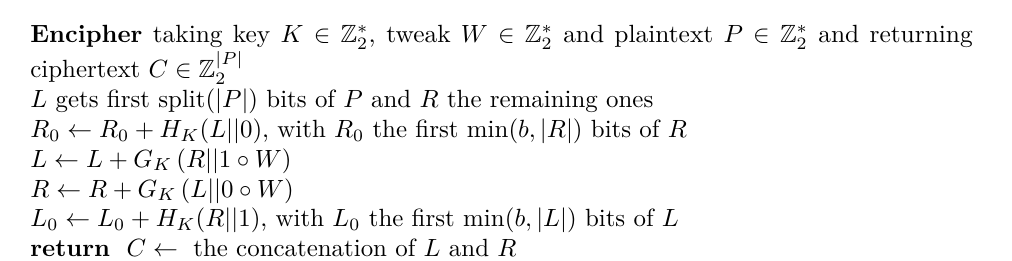
Algorithm 5 Definition of encryption in Farfalle-WBC[ H, G, ‘ ] Parameters: two PRFs H and G and alignment unit length ‘ ∈ N